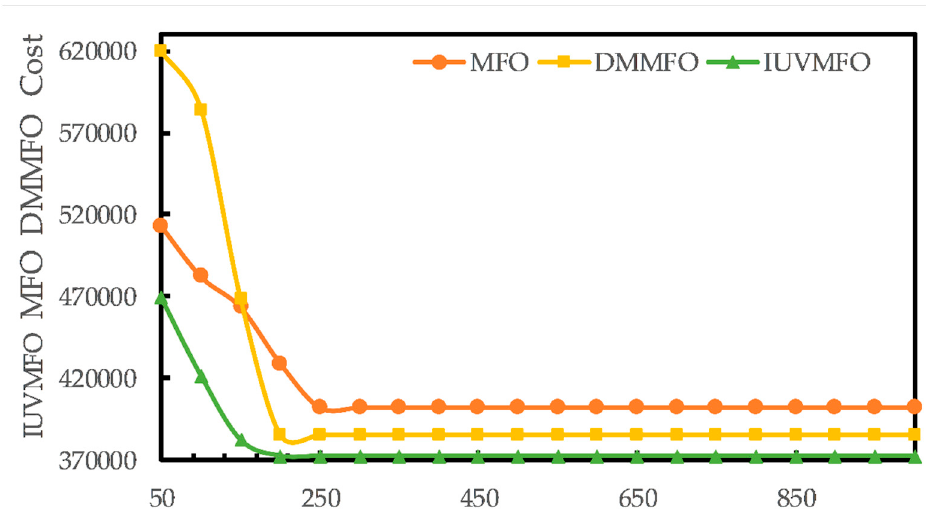
Figure 19. Curve diagram of algorithm test result.